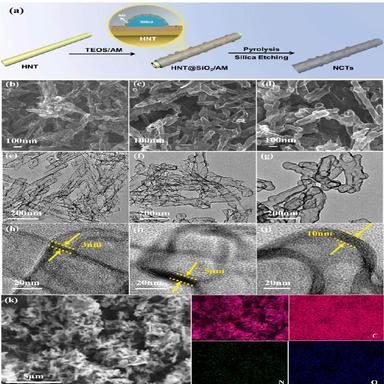
(a) Schematic illustration of synthetic route of NCTs, SEM and TEM images of (b, e, h) NCTs-0.1–30, (c, f, i) NCTs-0.1–70 and (d, g, j) NCTs-0.1–90, (k) SEM and corresponding elemental mapping images of NCTs-0.1–70.